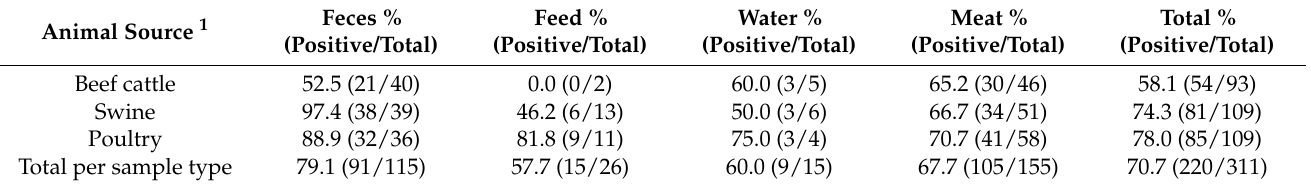
Table 2. Proportion of RT-PCR presumptive mcr -positive samples by animal source and sample